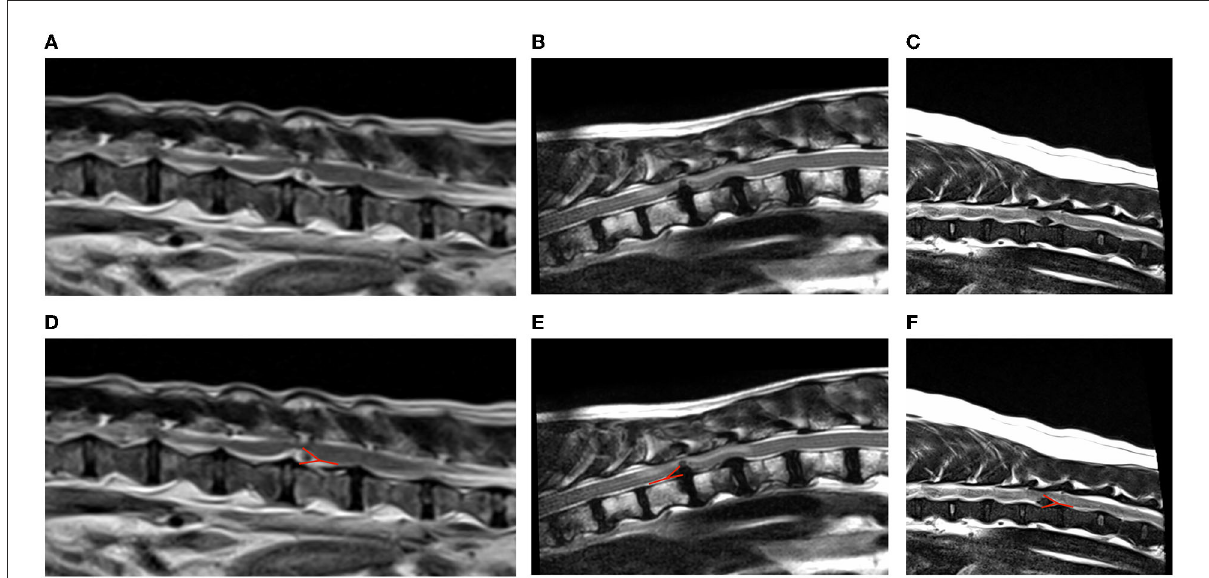
FIGURE1 Examples of “Y sign” on T2-weighted sagittal magnetic resonance images of dogs with intradural/extramedullary disc extrusion (A–C) . The red line in (D–F) highlights the “Y sign” appearance. (A,D) T2W sagittal sequence showing a L3-L4 intradural/extramedullary disc extrusion with the presence of a “Y sign” (Case 4). The T2-weighted homogenous hypointense disc material is appreciated surrounded by the T2W hyperintense CSF within the subarachnoid space giving a “Y” shape. This is caused by the division of the dura and the arachnoid layers as the latter is peeled off from the dura by the disc herniation which occurs between the dura and the arachnoid. (B,E) T2-weighted sagittal sequence showing a T11-T12 intradural/extramedullary disc extrusion (Case 6) with the presence of a “Y sign.” This is represented by T2-weighted hyperintense CSF in the caudodorsal and caudoventral aspects of the disc material. This “Y” shape is given by the separation of the dura and the arachnoid layers by the intradural disc material. Consequently, T2-weighted hyperintense signal (cerebrospinal fluid) is appreciated at the edges of the lesion displayed as a “Y” shape. (C,F) T2-weighted sagittal sequence showing a T11-T12 intradural/extramedullary disc extrusion (Case 7) with the presence of a “Y sign.” The presence of disc material within the subdural space creates a “Y” shape which corresponds to the splitting of the dura matter and the arachnoid matter in two separate lines “Y